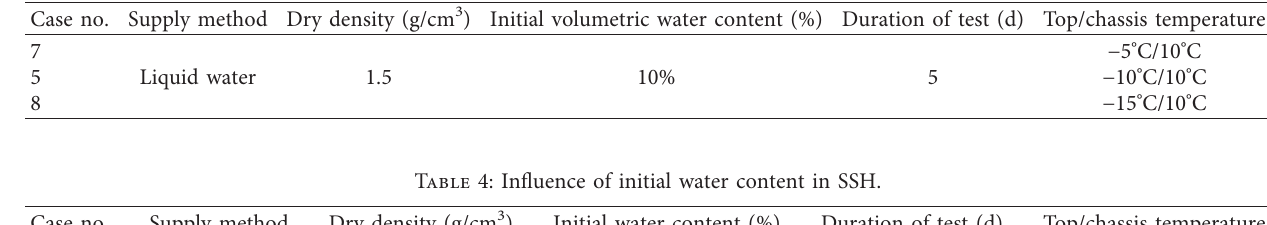
Table 3: Influence of temperature gradient in SSH.